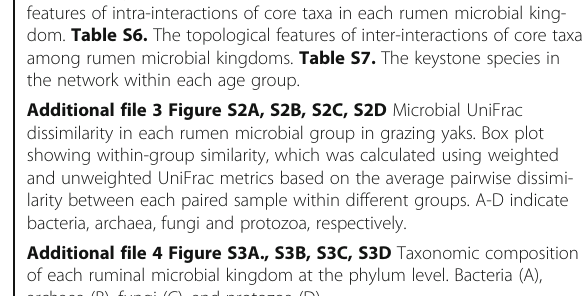
dom. Table S6. The topological features of inter-interactions of core taxa among rumen microbial kingdoms. Table S7. The keystone species in the network within each age